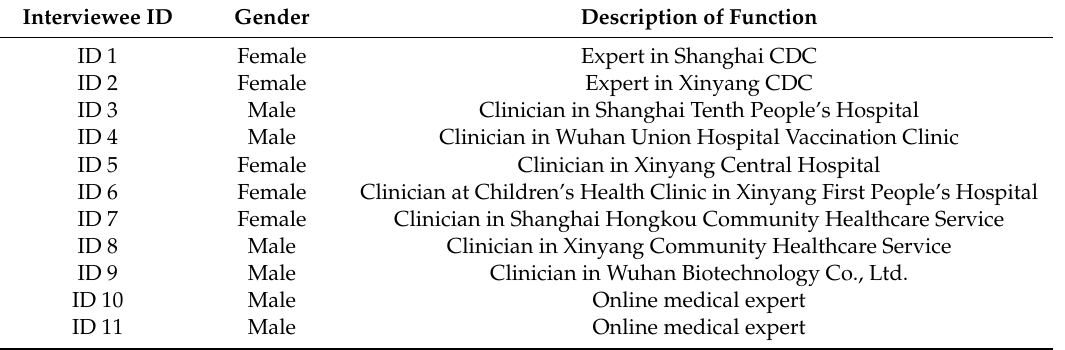
Table 1. Participant characteristics and descriptions of their